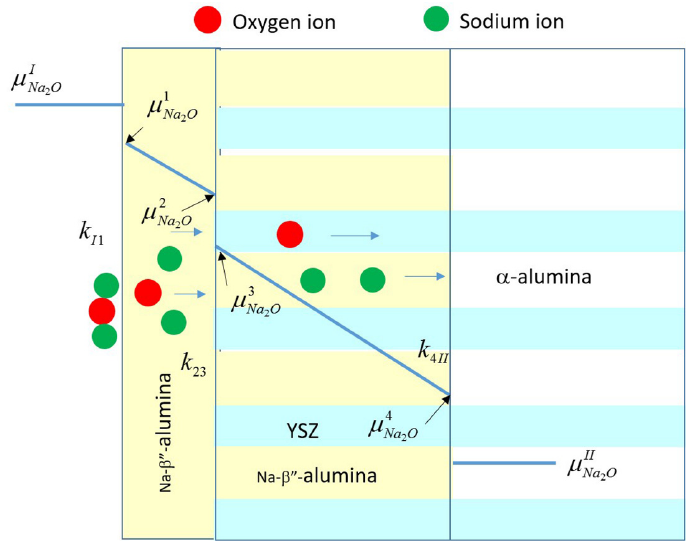
μ , through a , through a 2 2 O δ .